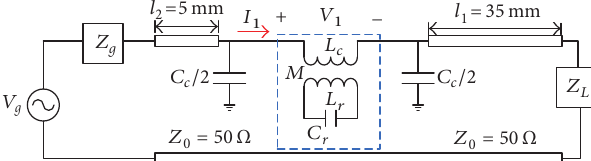
Figure 7: Equivalent circuit of a band suppressed cone type monopole UWB